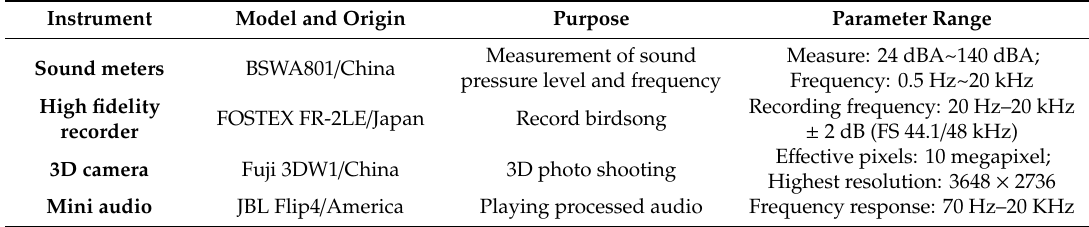
Table 2. List of experimental